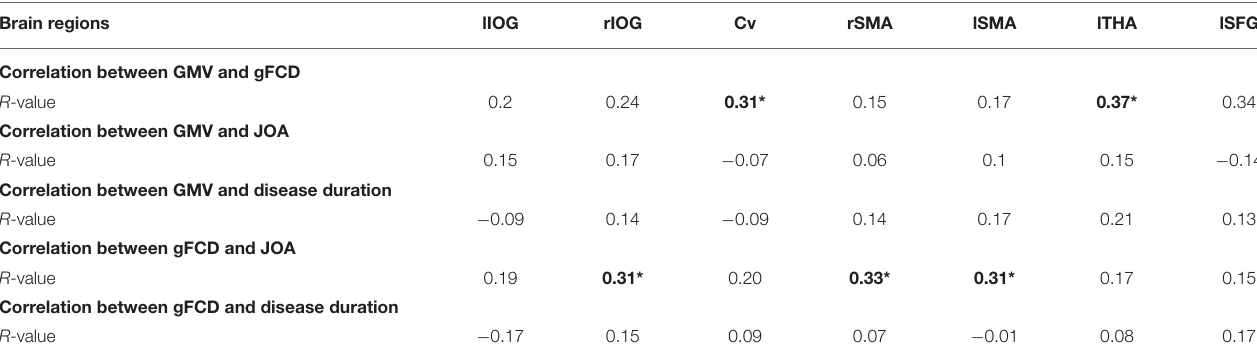
TABLE 3 | Correlation coefficients among gFCD, GMV, and clinical measures. Brain